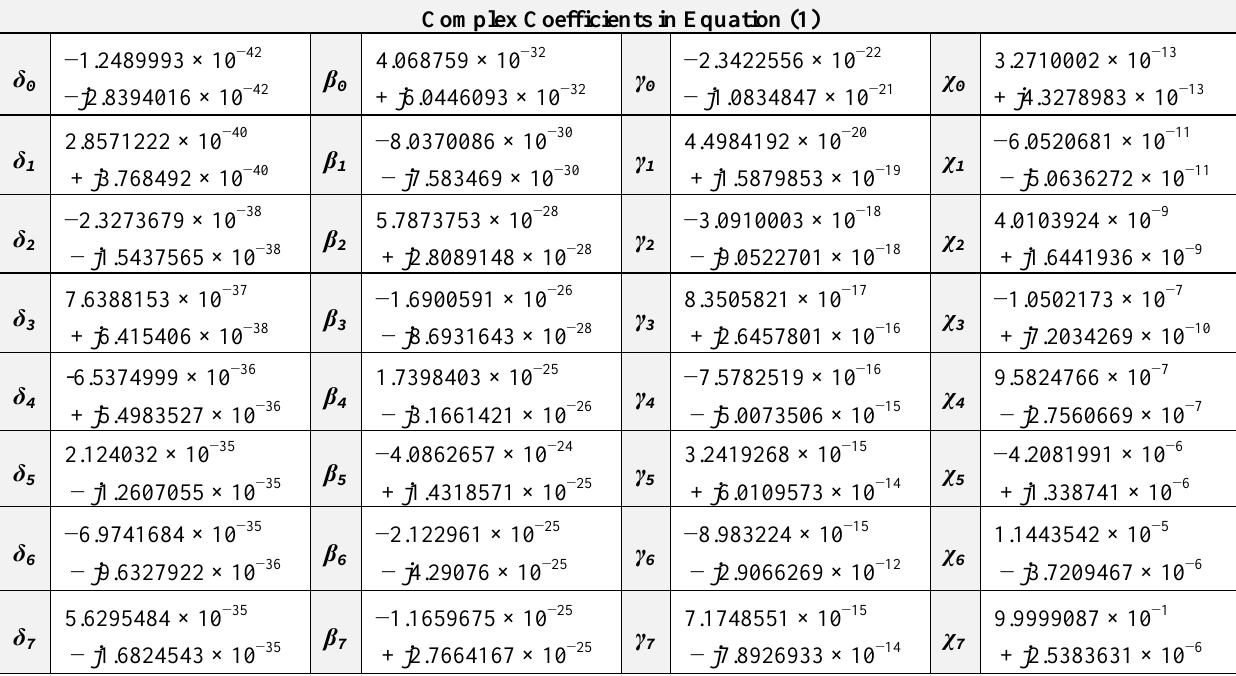
Table 1. Complex Coefficient for Equation